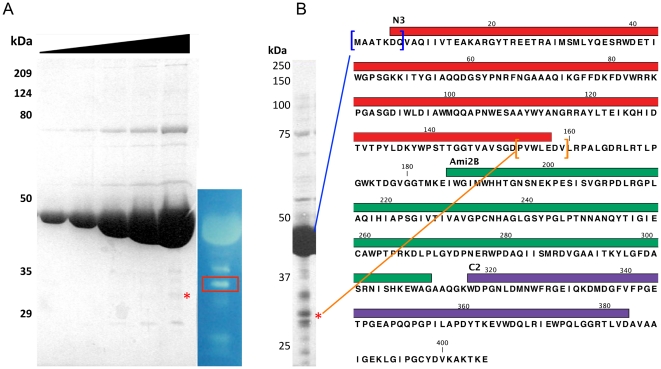
Identification of Corndog gp69 fragment with increased lytic activity.
A. Left, SDS PAGE with increasing amounts of Corndog gp69 sample illustrating the minute amount of protein (red asterisk) corresponding to one of the bands of high activity seen in the zymogram on the right (red box). B. Highly concentrated sample of Corndog gp69 from which a sample was taken (red asterisk) and submitted to Edman degradation. The control sequencing of the large band matched the N-terminal sequence of Corndog gp69 (blue brackets), while the smaller fragment corresponded to a sequence 153 aa C-terminal to the start of Corndog gp69 (orange brackets).